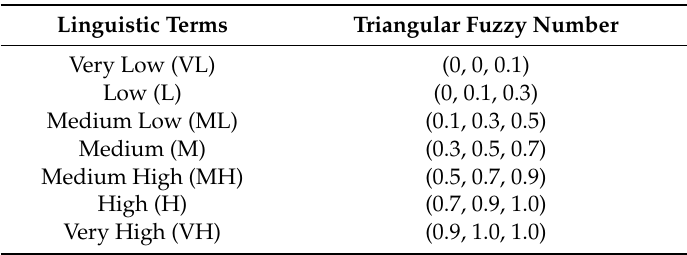
Table 1. Linguistic scale for the weights.